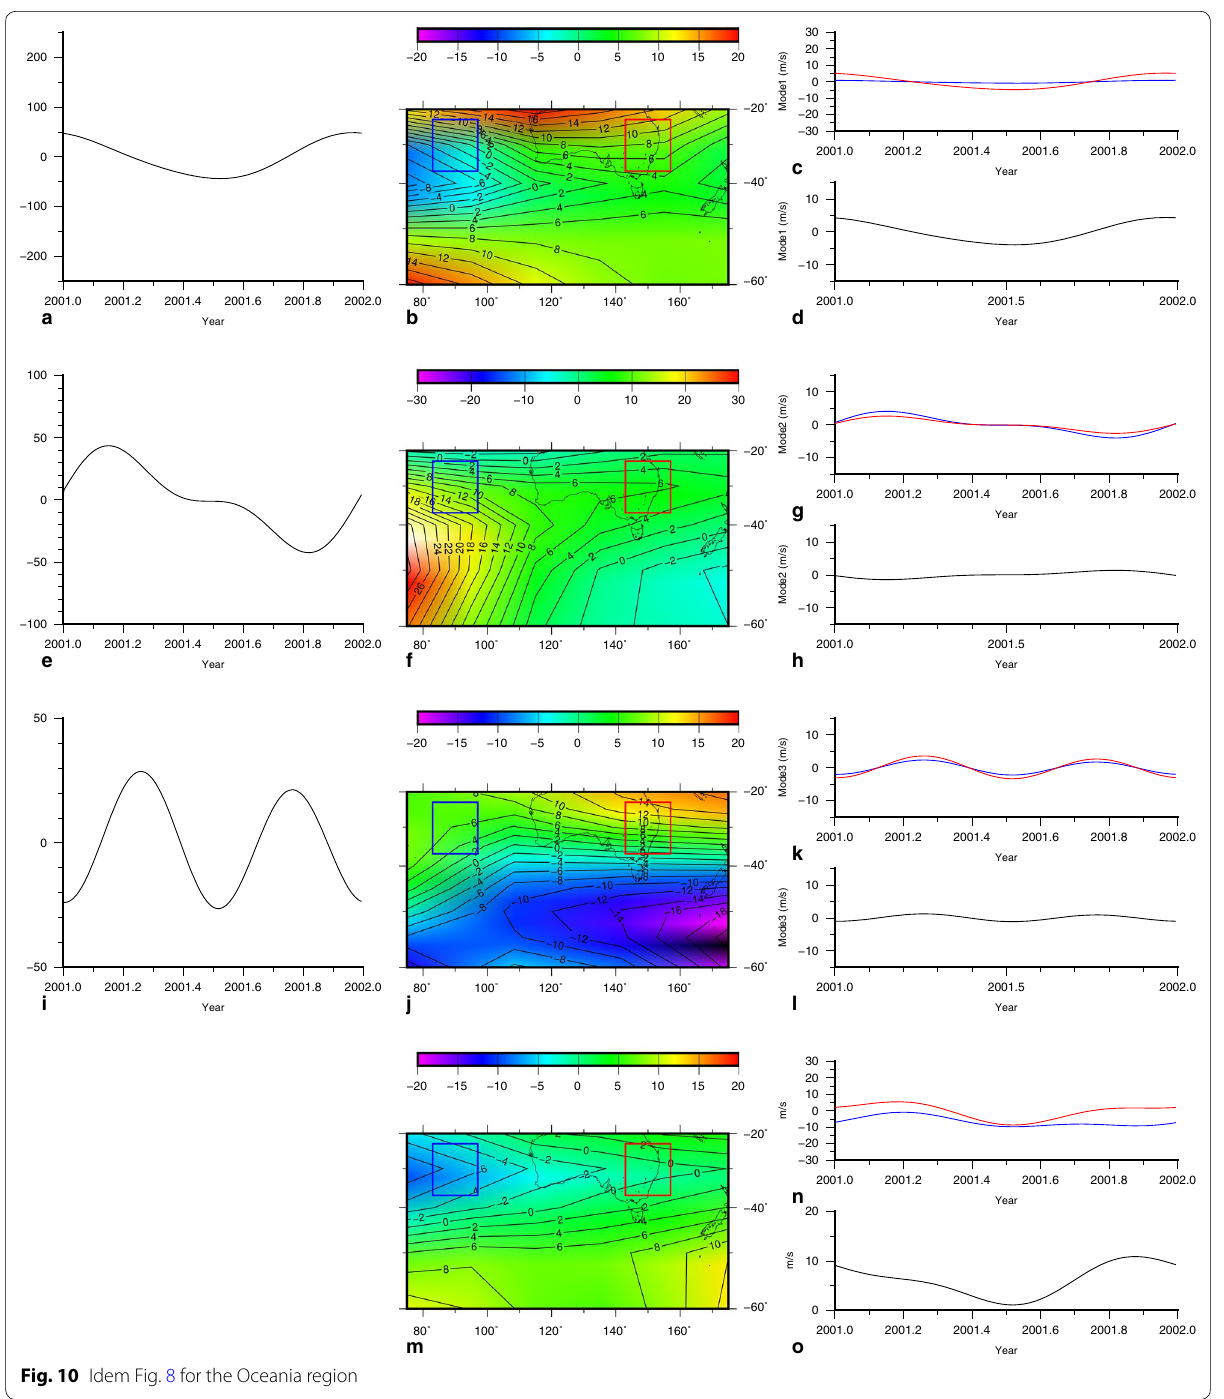
Fig. 10 Idem Fig. 8 for the Oceania